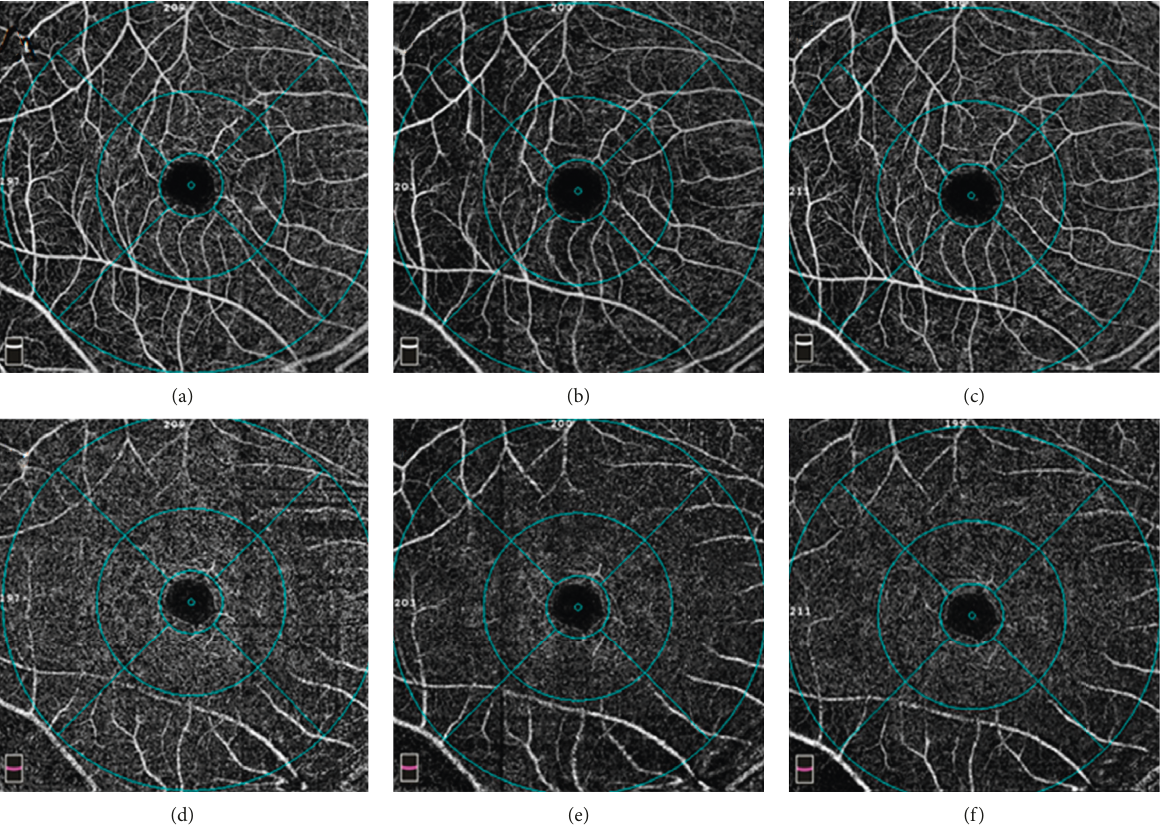
Figure 2: Optic coherence tomographic angiogram of the macular area from a 24-year-old female. The superficial vessel density at the fovea, parafovea, and perifovea was 16.3%, 55.4%, and 51.9% before surgery (a). The superficial vessel density at the fovea, parafovea, and perifovea was 12.2%, 43.5%, and 41.9% at 1day postoperatively (b). The superficial vessel density at the fovea, parafovea, and perifovea was 14%, 51.3%, and 47.9% at 2weeks postoperatively (c). The deep vessel density at the fovea, parafovea, and perifovea was 28%, 56.5%, and 51.3% preoperatively (d). The deep vessel density at the fovea, parafovea, and perifovea was 26%, 54%, and 42.3% at 1day postoperatively (e). The deep vessel density at the fovea, parafovea, and perifovea was 26.4%, 54.1%, and 45.7% at 2weeks postoperatively